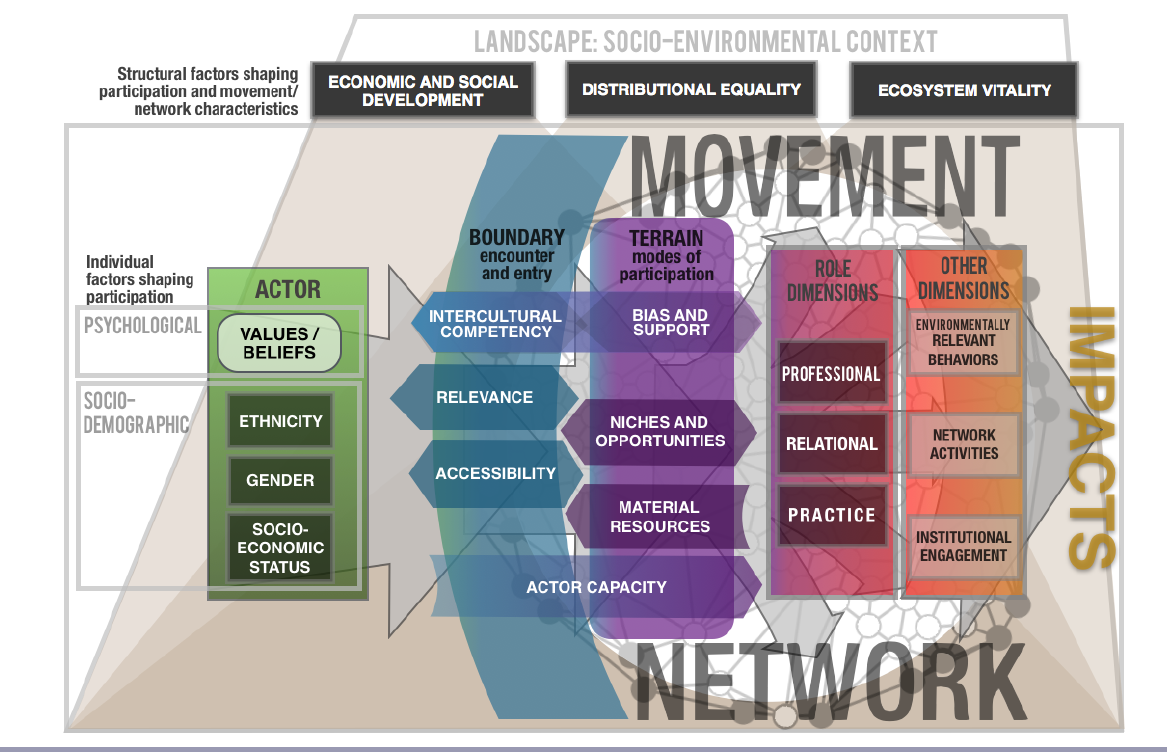
Fig. 7 . Boundary and terrain: a multilevel, multiloci model of the influence of socio-demographic and structural factors on participation in movements and networks. Movement and network characteristics interact with socio- demographic factors to shape participant demography at two thresholds or loci: (1) simple encounter of the movement/network by the potential participant, and entry of the participant into the movement/network, and (2) a multidimensional participation profile. Participation is also affected by socio-environmental context, both directly and indirectly, as structural factors act directly on participation while also modulating the effects of participant